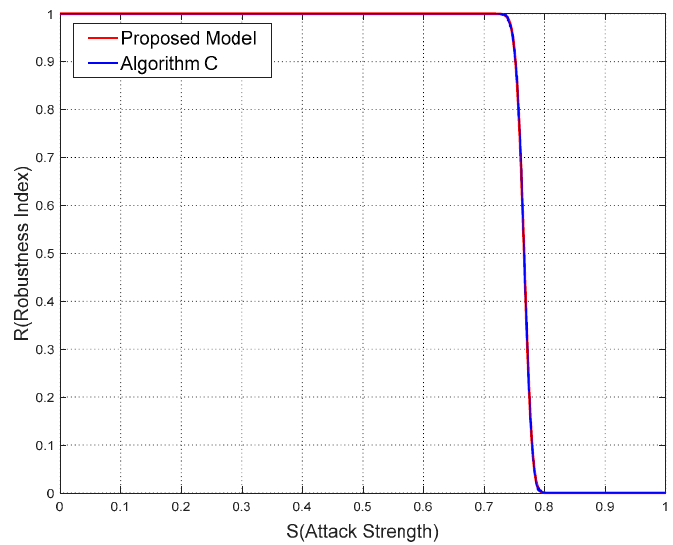
Figure 13. Comparisons of results from the proposed model and Algorithm C in Experiment 3.